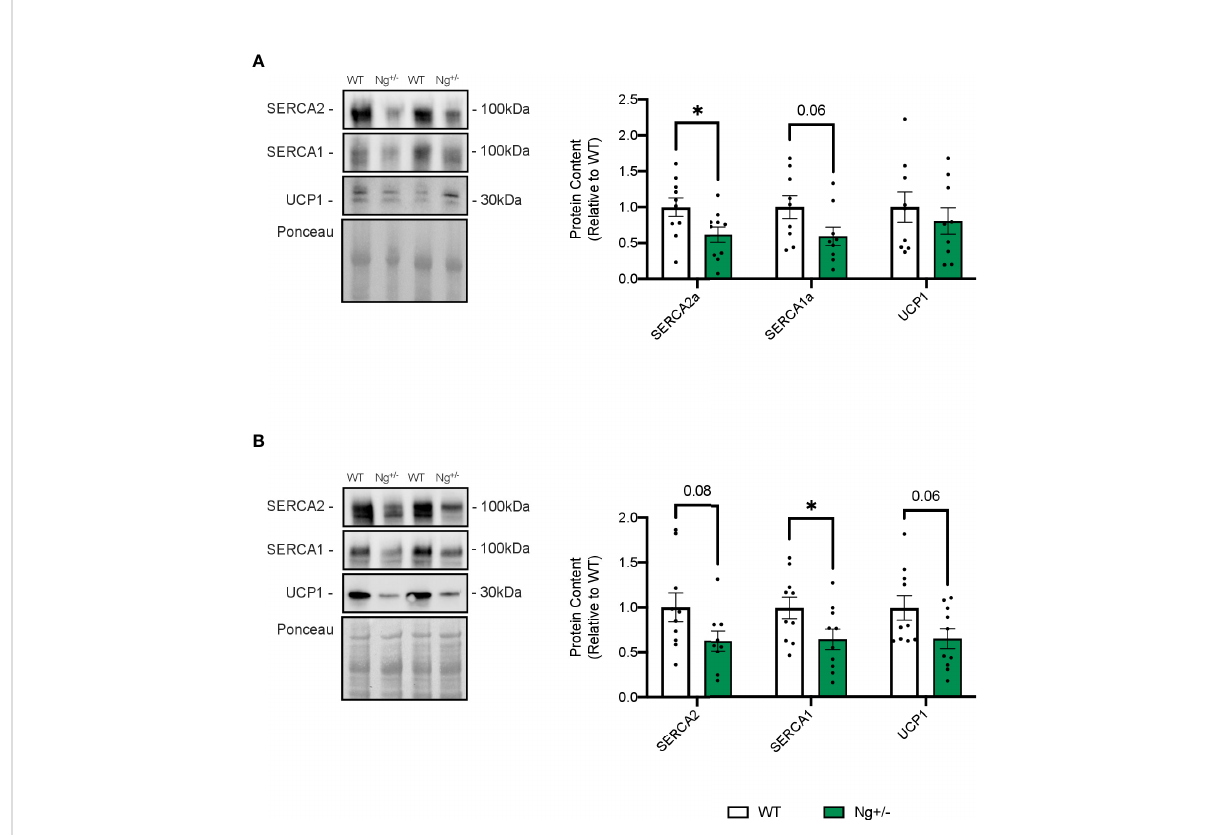
FIGURE 5 SERCA content is reduced in iWAT and BAT from Ng +/- mice. Representative Western blots and corresponding analyses of SERCA2a, SERCA1a, and UCP1 from iWAT (A) and BAT (B) . In both depots, reductions in both SERCA isoforms were observed with no changes in UCP1. * p < 0.05, values above bars indicate p values (n=9-10 per